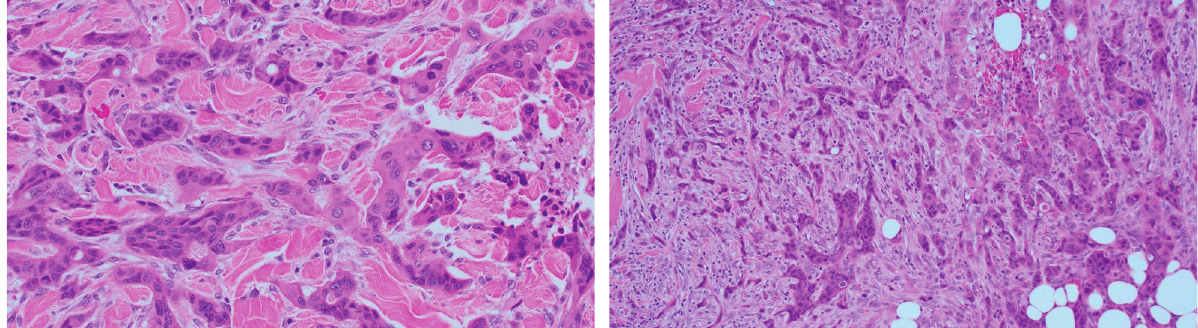
Figure 2: Microphotographs of the excisional biopsy of the skin lesion showing infiltrating cords and solid nests of epithelial cells within the deep dermis (H&E, 20x and 40x,